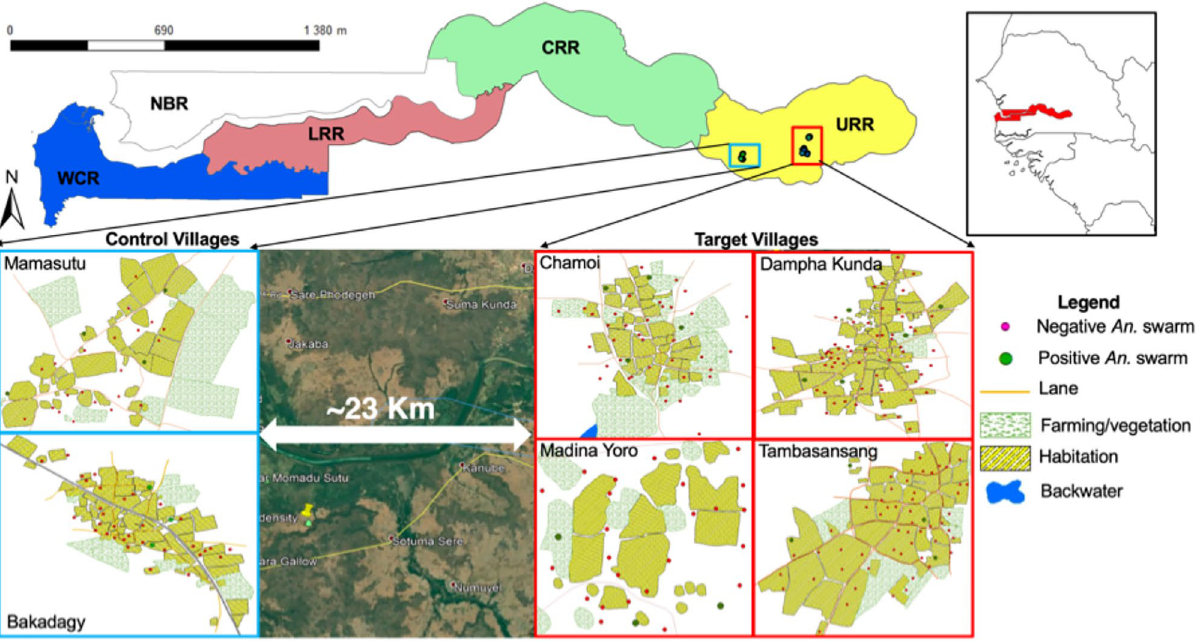
Figure 1. Distribution of Anopheles gambiae s.l. reproductive swarms in six villages of eastern Gambia. A The map of The Gambia shows the five administrative regions: WCR (West Coast Region); NBR (North Bank Region), LRR (Lower River Region), CRR (Central River Region) and URR (Upper River Region). The study area is in URR; Blue dots: control villages (Mamasutu and Bakadagy); Red dots: intervention villages (Chamoi, Dampha kunda, Tambasansang and Madina Yoro) the red dots. The control and intervention villages were ~ 23 km apart showing on the satellite image obtained from Google Earth Pro 7.3.4.8642. The green circles correspond to the positive Anopheles gambiae s.l. swarming positions and red circles correspond to the negative ones.